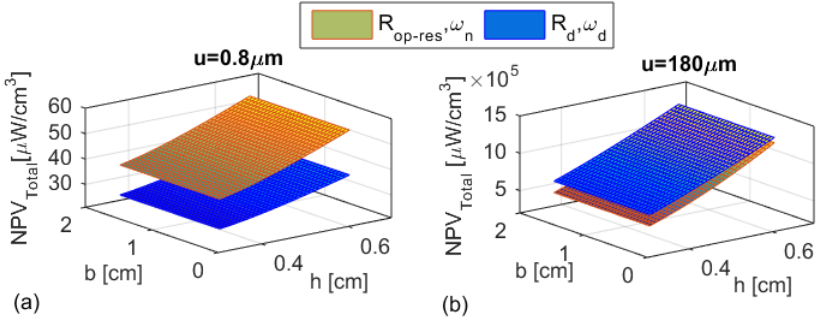
Figure 7. Normalized power to the total occupied volume (beam, tip mass, and motion) at input displacement of ( a ) u = 0.8 µm ( b ) u = 180 µm ( f n constant at 155 Hz, free length of 9.62 cm, mass ratio varies from 0 to 0.52 for the corresponding total thickness from 0.382 to 0.682 cm, respectively, and ζ m = 0.01).